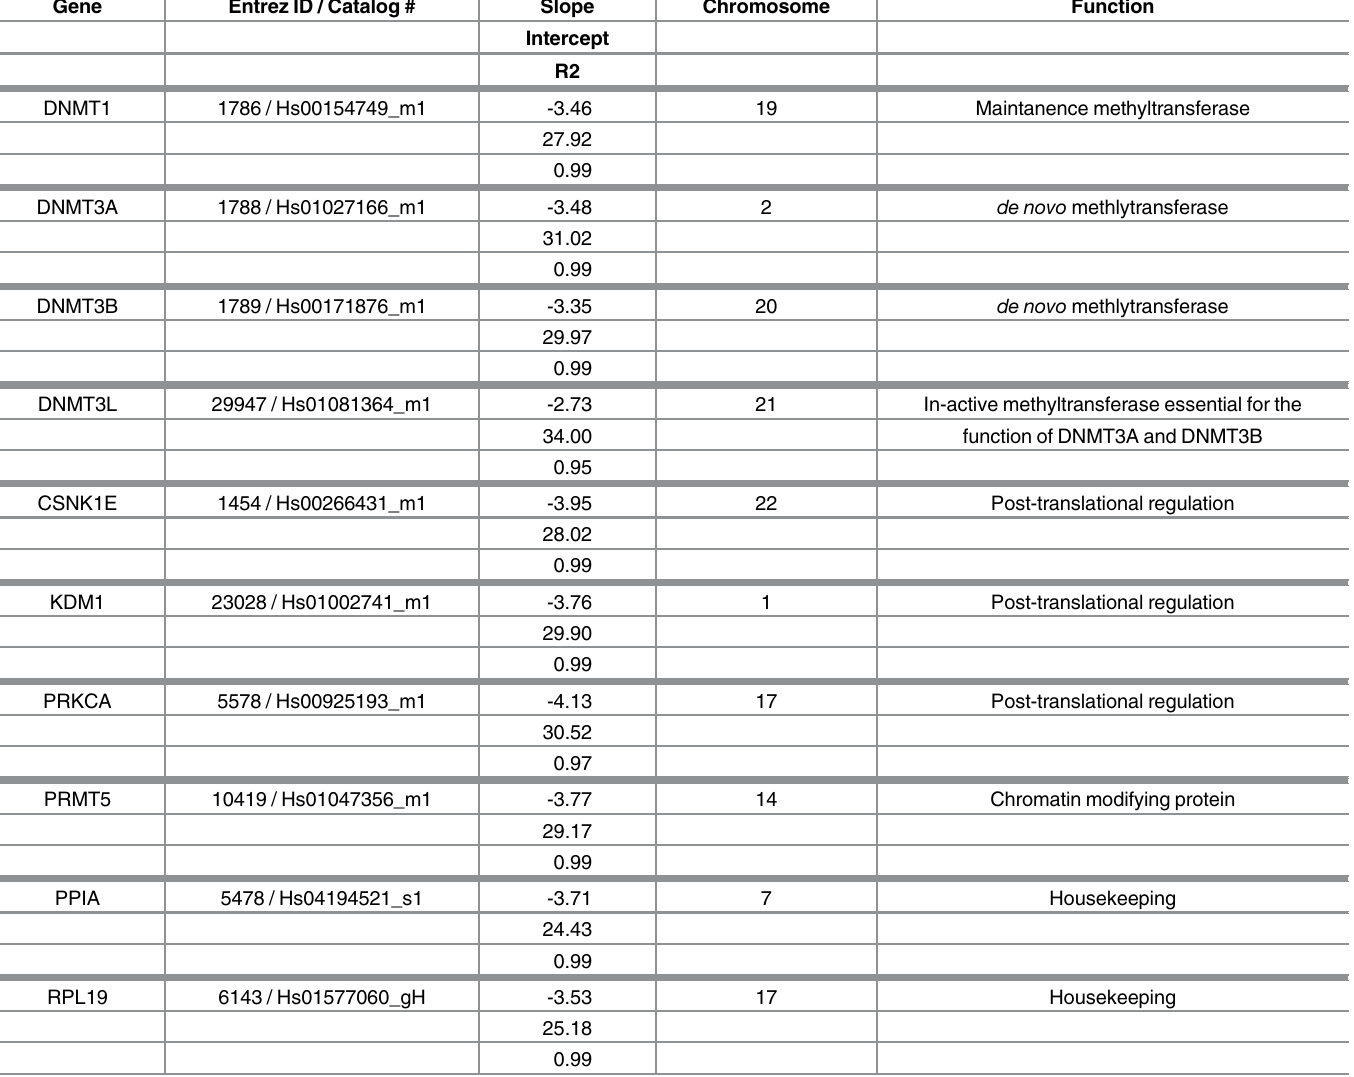
Table 2. Genes involved in DNA methylation processes (including two housekeeping genes) and qPCR efficiency information (Taqman 1 assays; Life Technologies).